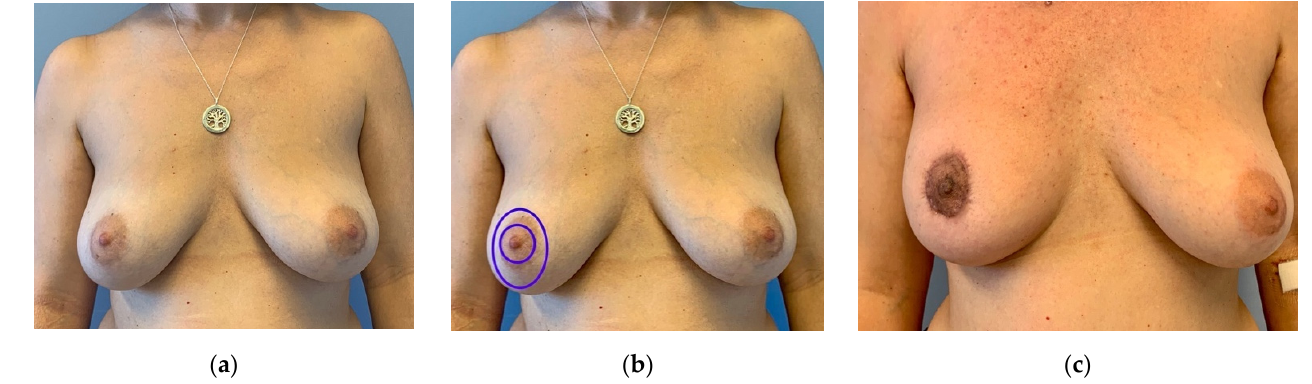
Figure 4. ( a ) Preoperative: 35-year-old patient with a multicentric invasive cancer on the right side required a mastectomy. Moderate ptosis. Right side slightly larger and more ptotic than left side. Sternal notch to nipple distance 24 cm, nipple to IMF distance 12 cm. ( b ) Schematic marking of the circumareolar incision to harvest the NAC (inner circle) and skin-reducing incision (outer circle). Without skin adjustment, the new breast shape would be flat. ( c ) Three months after circumareolar mastectomy, DIEP-flap reconstruction and free NAC graft (histologically controlled). Additional circumareolar skin was resected. Mastectomy and flap weight were identical (420 g). Patient is un- dergoing adjuvant chemotherapy. Slight hyperpigmentation of the NAC is visible. An alignment of the left breast is planned after completing adjuvant therapy.